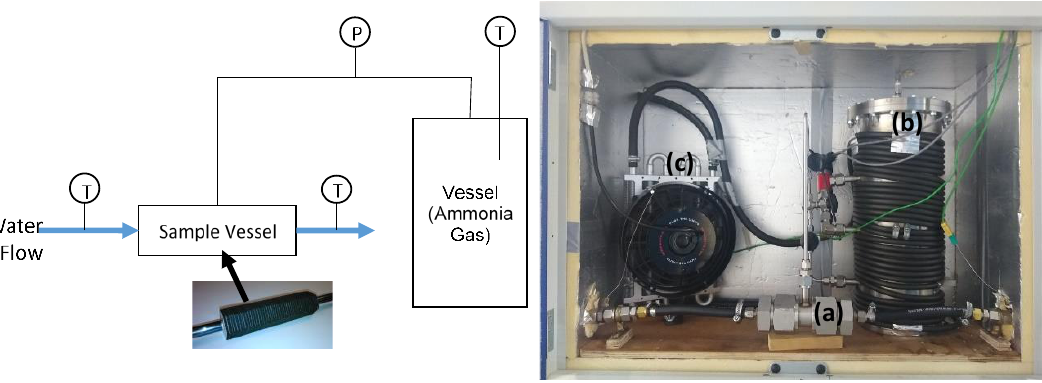
Figure 8. Large temperature jump apparatus. Schematic ( left ) and actual system ( right ). ( a ) Sample vessel, ( b ) receiver vessel wrapped with tubing, and ( c ) enclosure heater (fan coil). Key: P=pressure transducer, T=temperature sensor.